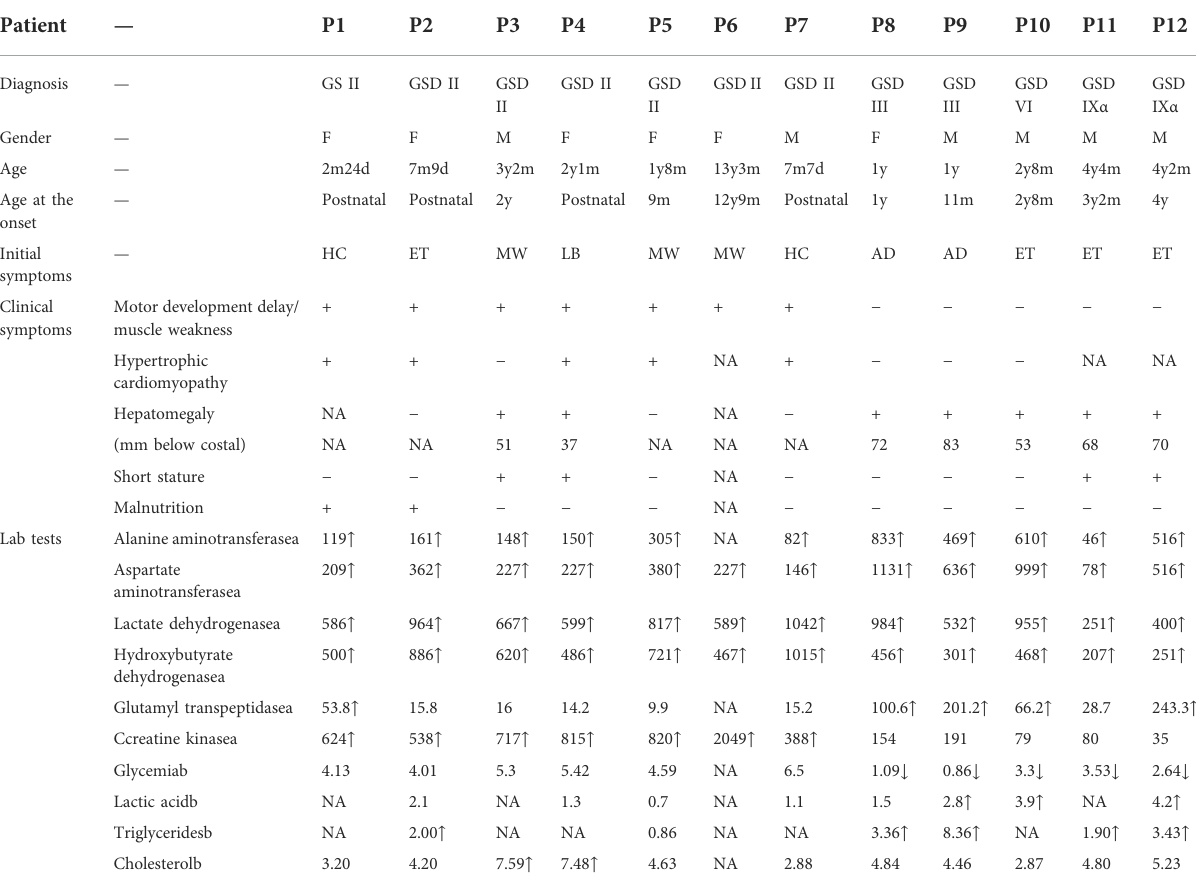
TABLE 1 | The clinical and laboratory features of the Chinese patients with GSD.